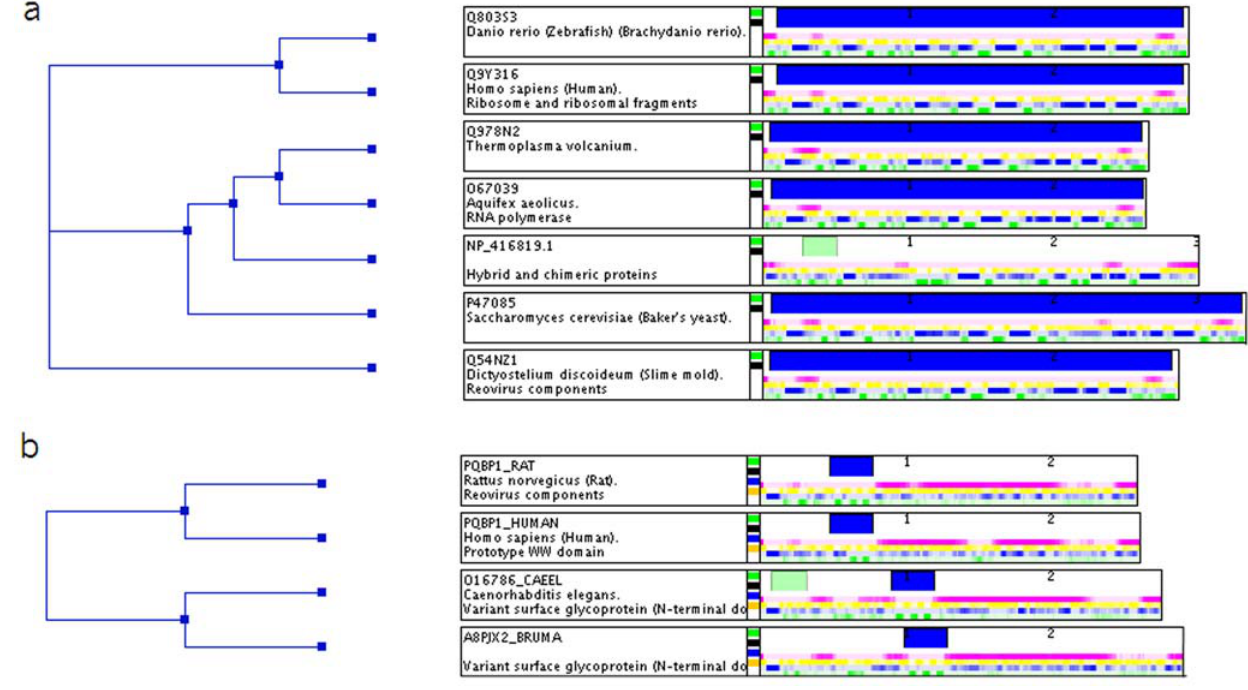
Figure 2. Results of similarity searches assessed with ProteinArchitect. a) The best BLAST hits in a number of proteomes are displayed. While there is a clear similarity between the eukaryotic and most prokaryotic proteins in terms of secondary structure propensities, the third protein, the best hit in E.coli, differs considerably in architecture. Therefore, this protein is not likely to be a homolog with similar structural features. b) Assessment of the results of a BLAST search in Uniprot with the ‘‘Putative uncharacterized protein’’ O16786_CAEEL as a query. Despite the weak similarity in most parts of the protein with mammalian proteins (31% identity), overall architecture is quite similar. To distinguish conserved from more variable features, a close ortholog of the human protein, the rat protein, has been included, as well as another nematode protein (A8PIX2_BRUMA) from Brugia malayi, which is 48% identical to the C.elegans query protein. Note also the conserved C-terminal region that shows a characteristic combination of features but no disorder prediction (pink), flanked by disordered regions with a propensity for alpha-helices (blue).